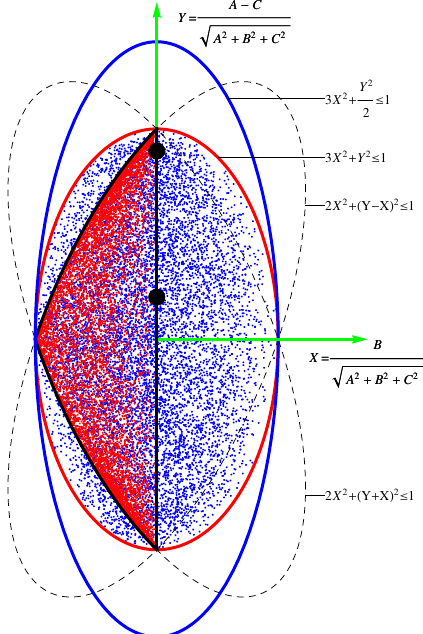
Figure 2 . Various bounds on X and Y de(cid:12)ned in eq. (3.4), converted from (cid:12)gure 1 to a two- dimensional form. The two black dots in the middle indicate the SM values, the lower and upper one corresponding to NC (e.g. (cid:23) (cid:22) + e (cid:0) scattering) and NC+CC (e.g. (cid:23) e + e (cid:0) ), respectively. The Majorana bound consists of parts of the two black dashed ellipses and a central vertical line, described by the expressions (also derived in the appendix) Majorana bound :